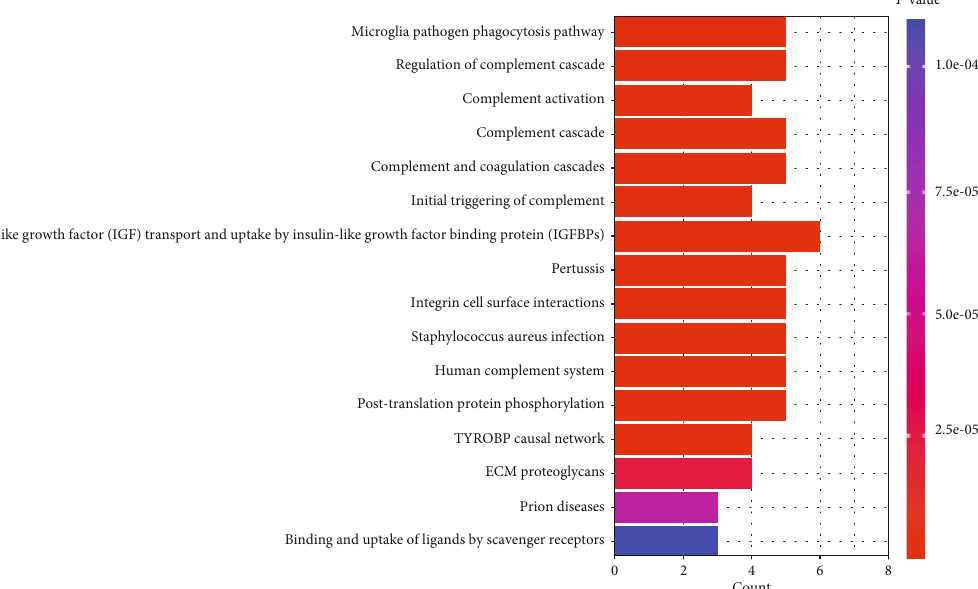
Figure 8: KEGG pathway analysis of hub genes. A total of 16 pathways are screened out according to the criteria of P < 0 : 05 . The longitudinal axis displays the name of di ff erent pathways, and the transverse axis shows the count of enriched genes. In addition, the length of the bar is showed according to the ascending order of the number of gene counts, while the color of the bar is displayed in a gradient from blue to red according to the descending order of the P